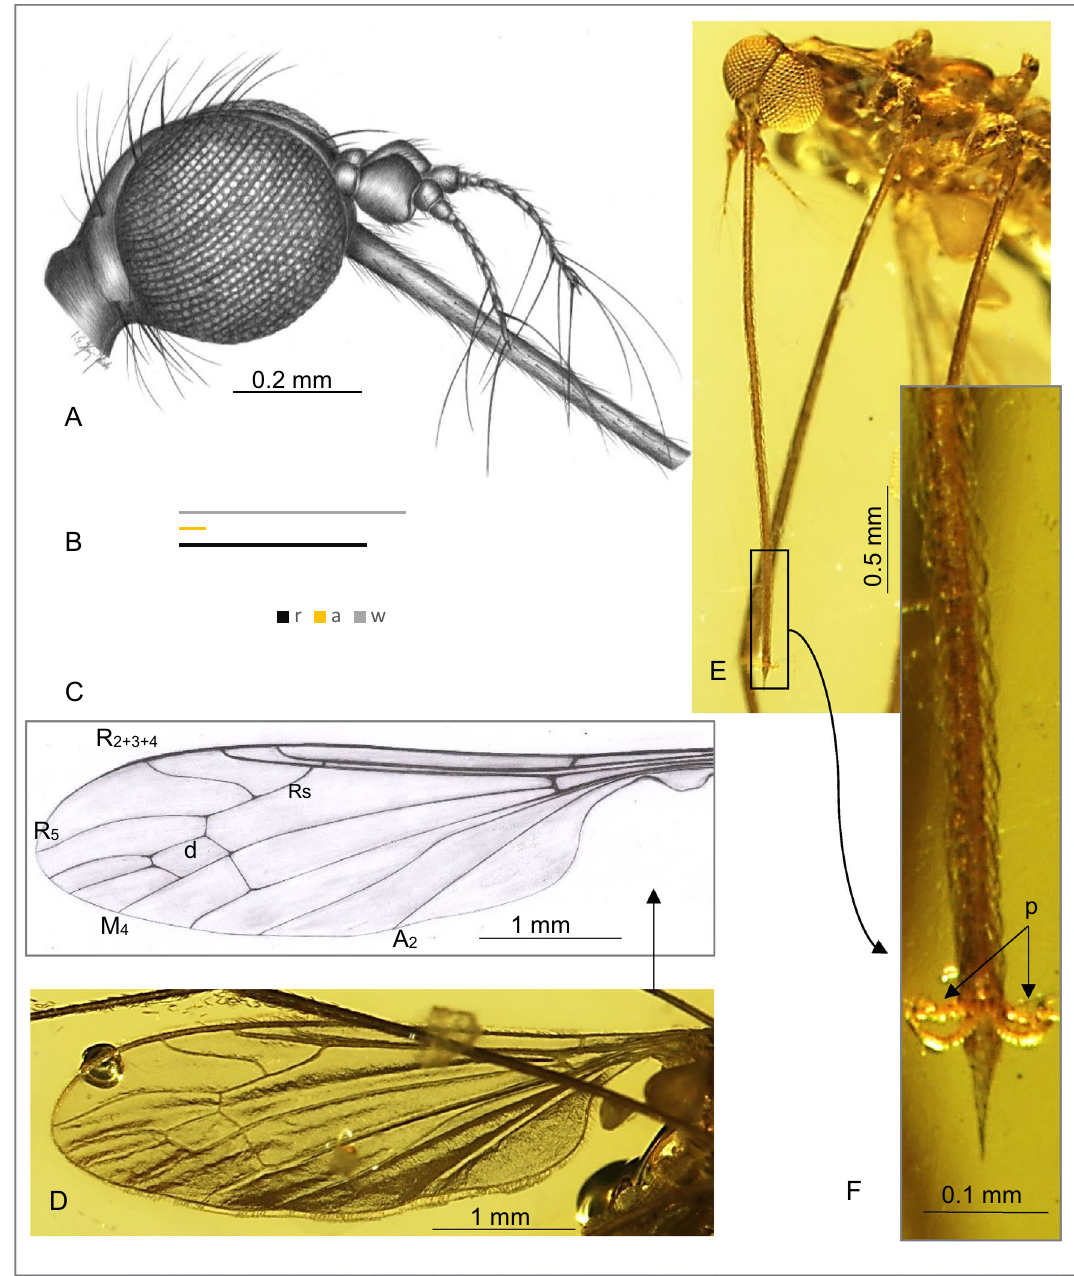
Figure 4. Toxorhina ( Ceratocheilus ) christelius sp. nov. (Limoniidae), inclusion in Baltic amber, ( A ) No. CCHH 832-2 (male), (coll. Ch. and H.W. Hoffeins), specimen from Senckenberg Deutsches Entomologisches Institut (SDEI) Müncheberg, Germany: ( A ) drawing of head with part of rostrum, lateral view (reconstruction); ( B ) relation between the length of rostrum (r), antenna (a) and wing (w); ( C – F ) No. MP/4441 (male), holotype, specimen from Institute of Systematics and Evolution of Animals, Polish Academy of Sciences, Kraków, Poland (ISEA PAS): ( C ) drawing of wing; ( D ) photograph of wing; ( E ) head, frontal view; ( F ) tip of rostrum with palpi well